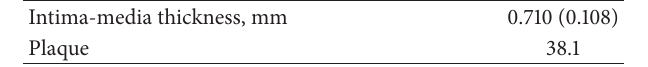
Table 2: Carotid atherosclerosis in 208 patients with rheumatoid